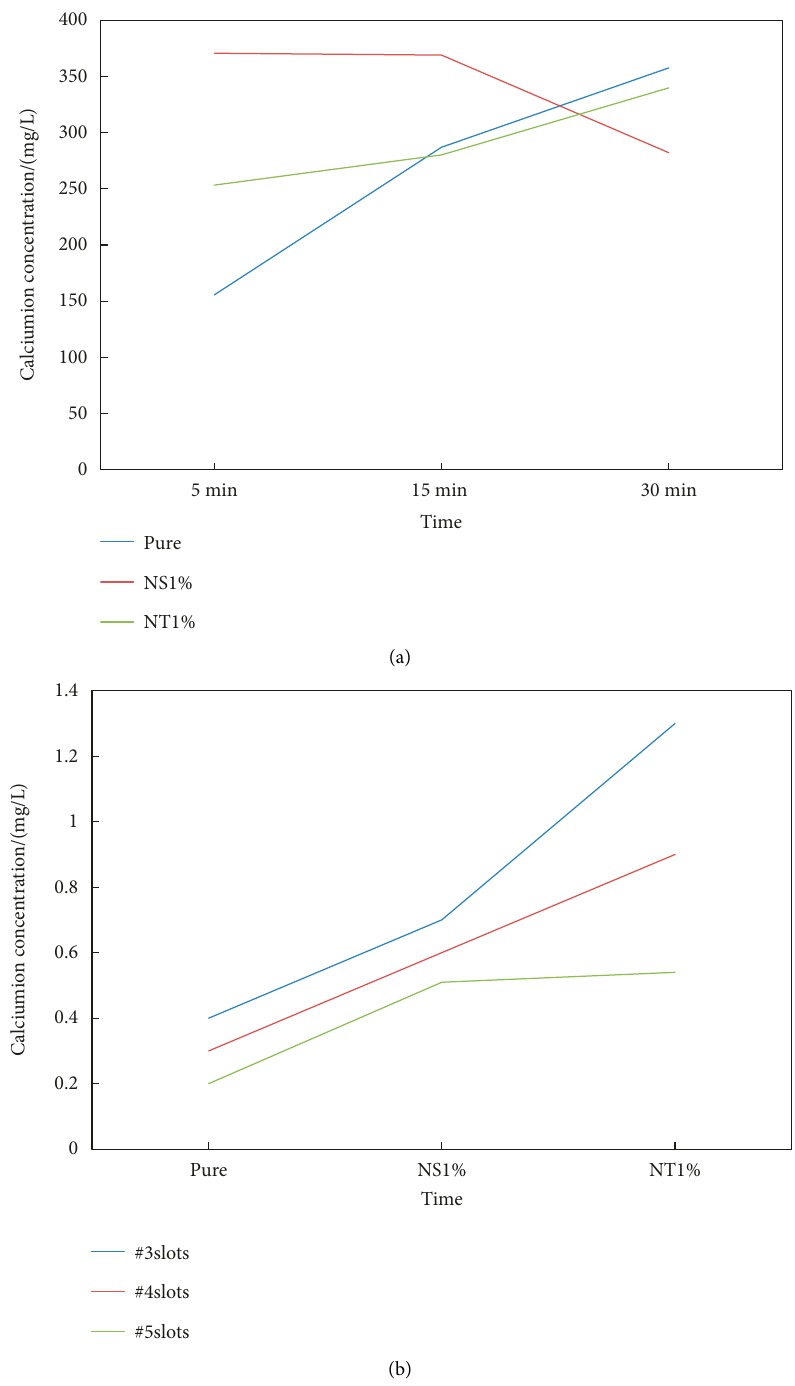
Figure 8: Cement ion dissolution and calcium ion diffusion rate diagram. (a) The concentration of calcium ions dissolved in cement hydration with different nanomaterials. (b) The diffusion rate of calcium hydrate in cement doped with different No. 1 and No. 2 tanks contain the migration of cement comparison. Figure 8(b) is the concentration of calcium ion particles, the No. 3, No. 4, and No. 5 tanks are selected as the diffusion during the hydration process of cement mixed with calibration tanks for ion diffusion. It can be seen that with different nanomaterials at 5 min. The three groups represent the increase of distance, the concentration of calcium ions the undoped nanomaterial group, the 1% NS doped group, gradually decreases, and the order of calcium ion concen- and the 1% NTdoped group, respectively. The reaction times tration is slot 3 > slot 4 > slot 5. The diffusion of calcium ions are 5 min, 15 min, and 30 min, respectively. Since both the